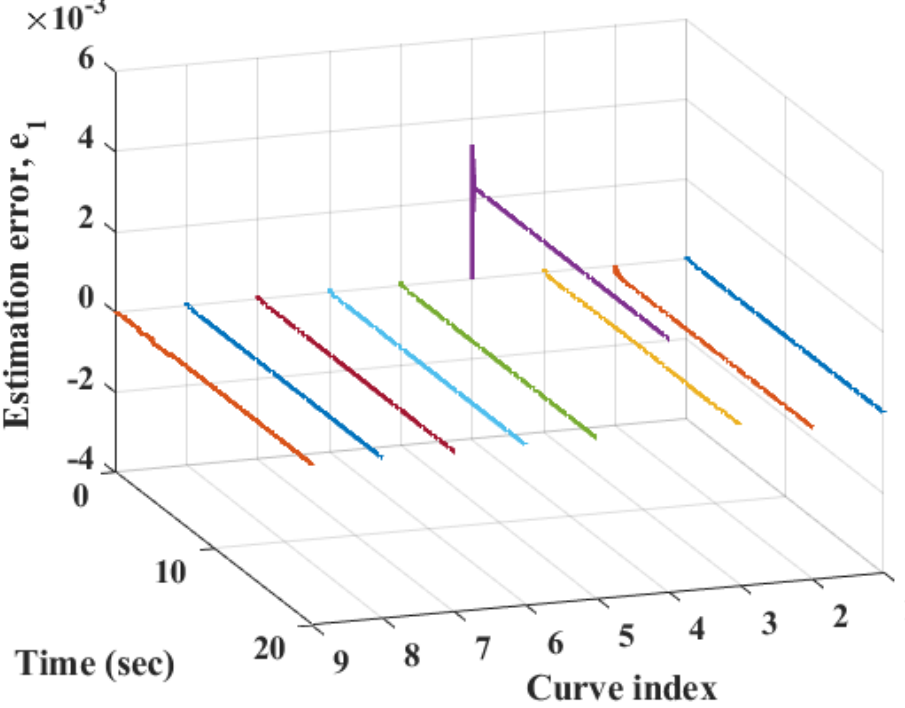
Figure 4. The estimation errors with curve indices from 1 to 9 represent LESO, NLESO types I, II, III, IV(a), IV(b), V, and VI, and NHOESO, respectively.